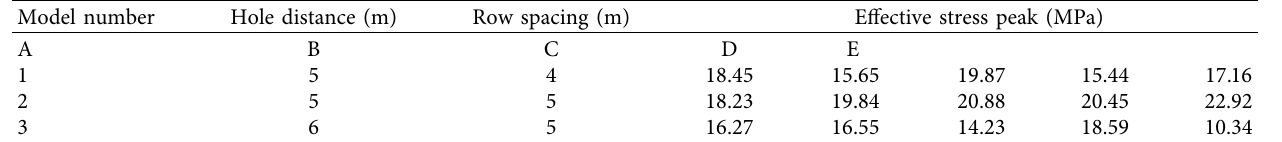
Table 3: Statistical table of peak effective stress at special points.